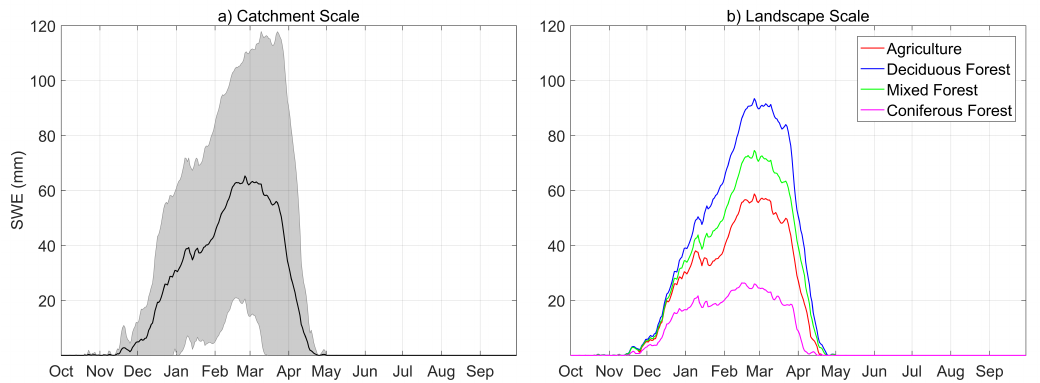
Figure 4. SWE simulations at the ( a ) catchment and ( b ) landscape scale. The grey envelope in (a) illustrates the inter-annual variability for the 1996–2019